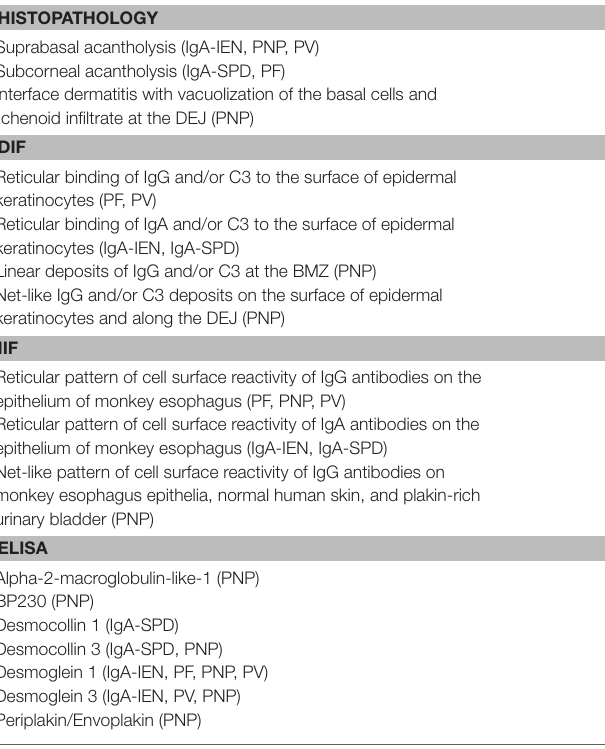
TABLE 1 | Diagnostic algorithm in pemphigus [adapted from Witte et al. (76)].